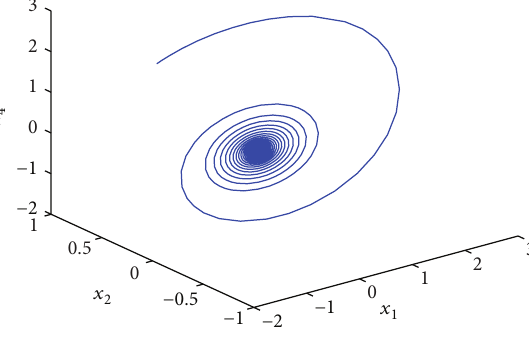
Figure 13: Waveform for system (2) with 𝑐 = 1 .